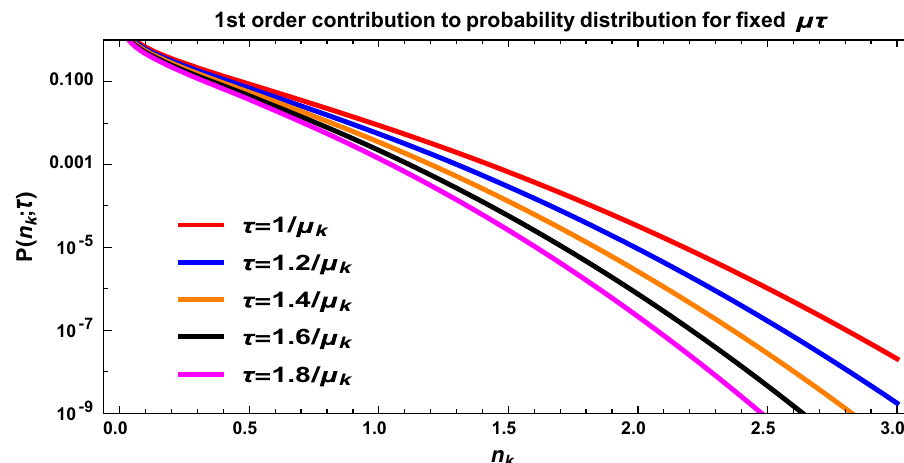
1st order contribution to probability distribution for